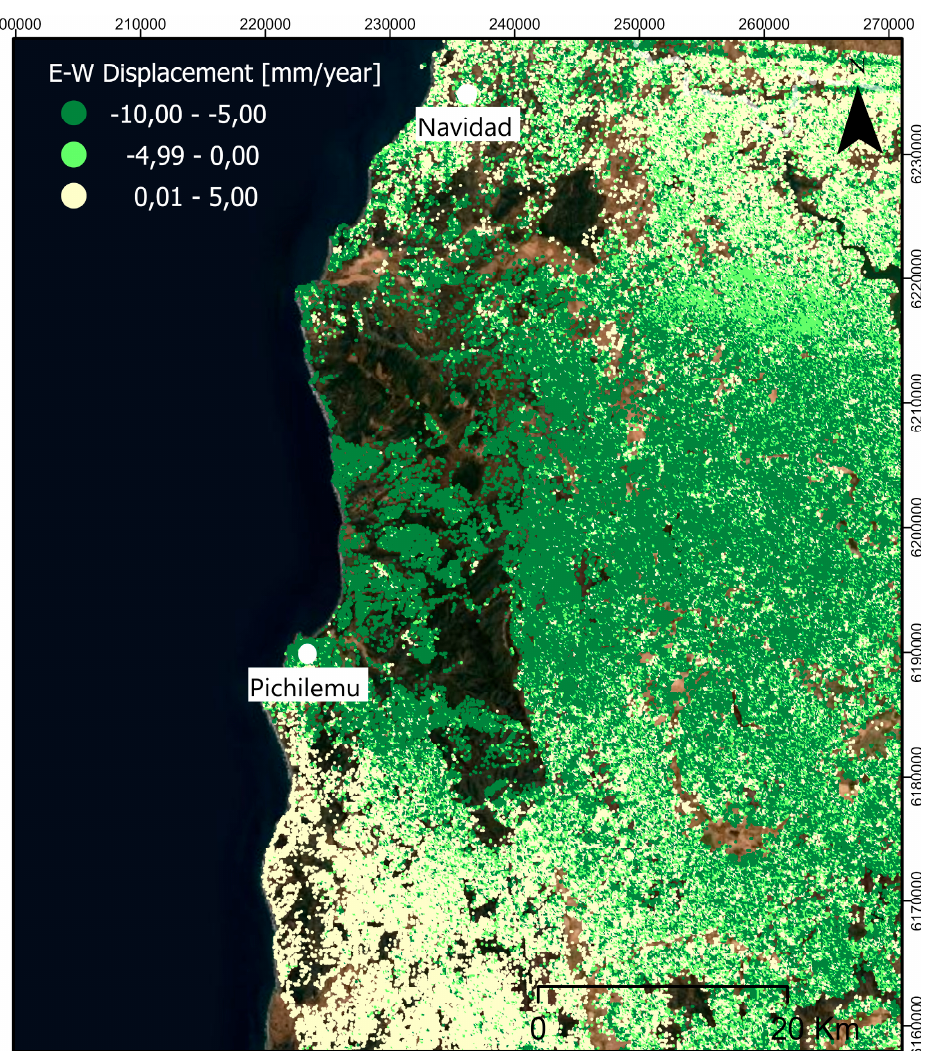
Figure 9. E-W displacement component estimation map (mm/year) for the subsidence area.